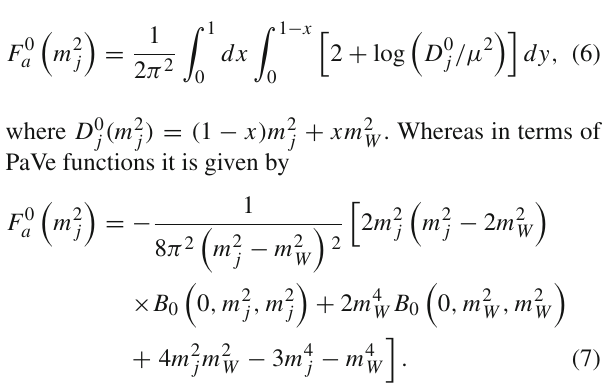
Fig. 1 Feynman diagrams for the L − → (cid:3) − (cid:3) (cid:5)− (cid:3) (cid:5)+ decays in the pres- ence of lepton mixing (i.e., non-vanishing neutrino masses). In ‘renor- malizable’ R ξ gauges, similar diagrams need to be added, which are obtained replacing the W gauge bosons by the respective would-be Goldstone bosons. Notice that diagram d only involves the Z gauge boson, whereas the a , b and c diagrams can also be mediated by the